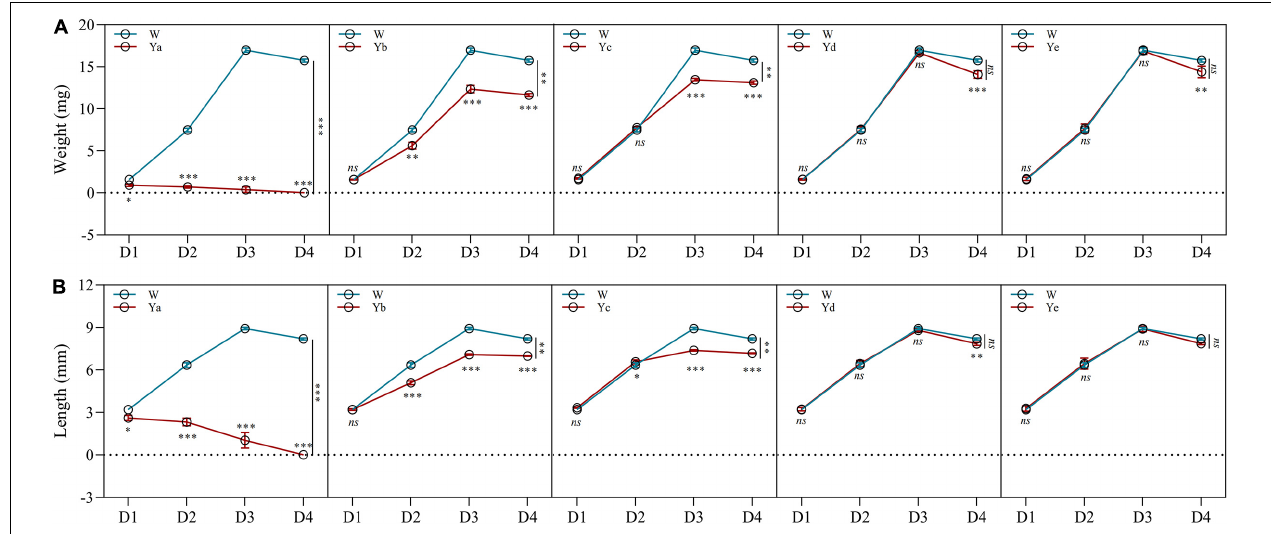
FIGURE 1 | Effects of different dilutions of P. aeruginosa on the development of housefly larvae. (A) Body weight was significantly changed over time in housefly larvae with different dilutions of P. aeruginosa . (B) Body length was significantly changed over time in housefly larvae with different dilutions of P. aeruginosa . Wa, Ya, Yb, Yc, Yd, and Ye represent housefly larval samples fed diets with sterile water, P. aeruginosa stock solution, and the stock solution diluted 10 2 , 10 4 , 10 6 , and 10 8 fold, respectively. Each treatment included three biological replicates. Data are represented as the mean ± SEM. Repeated measures ANOVA followed by Sidak correction was used for multiple comparisons. * p < 0.05, ** p < 0.01, *** p < 0.001.